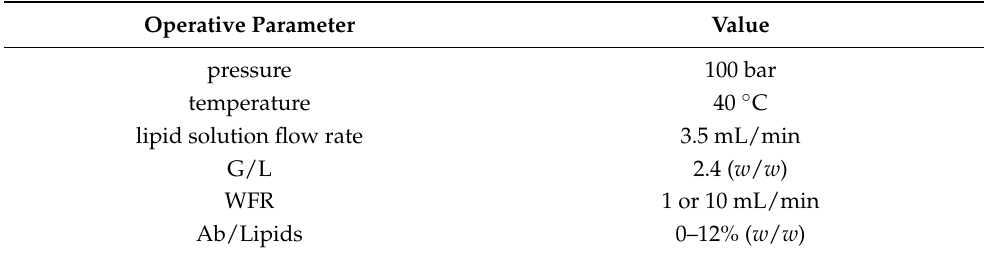
Table 1. Operative parameters used for the production of loaded liposomes by the SuperLip apparatus. G/L: gas-to-liquid ratio, WFR: water solution flow rate, Ab/Lipids: antibody-to-lipid mass ratio. Operative Parameter Value pressure 100 bar temperature 40 ◦ C lipid solution flow rate G/L Ab/Lipids 0–12% ( w / w